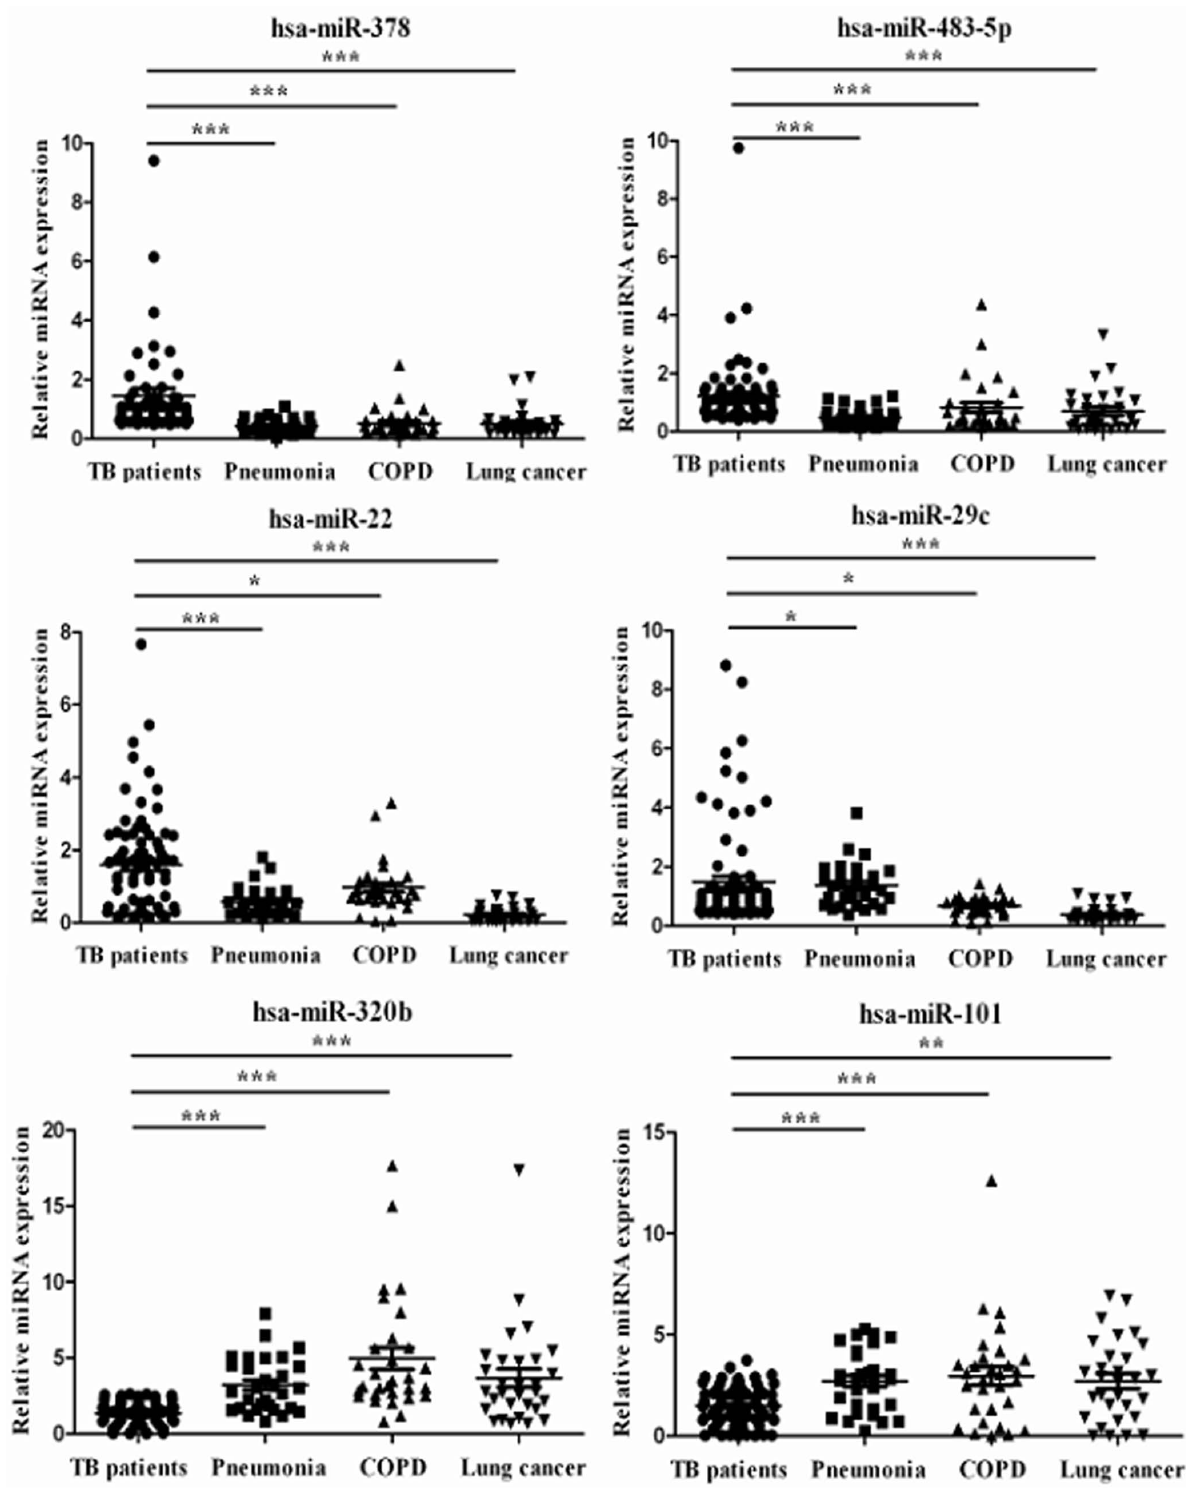
Figure 2. The qRT-PCR assay validation of miRNA expression levels in samples from pulmonary TB patients versus pneumonia, COPD or lung cancer patients. We analyzed the expression of six serum miRNAs (hsa-miR-378, hsa-miR-483-5p, hsa-miR-22, hsa-miR-29c, hsa-miR- 320b and hsa-miR-101) in 128 pulmonary TB patients versus 30 pneumonia, 30 COPD or 30 lung cancer patients, respectively. The 2 2 DD CT method was used to normalize the relative gene expression data in the qRT-PCR assay. Hsa-miR-16 was set as the reference gene. The miRNA expression value in one subject with pulmonary TB was normalized to 1. Statistical analysis was performed using the nonparametric Mann-Whitney test. *** P , 0.001, ** P , 0.01, * P , 0.05. TB, tuberculosis; COPD, chronic obstructive pulmonary disease.